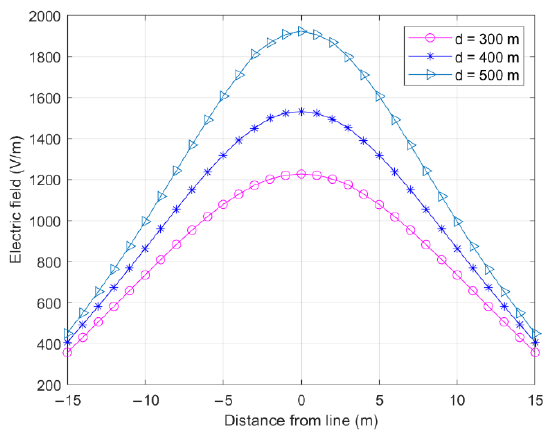
Figure 8. Slip configurations of different lengths and sags.